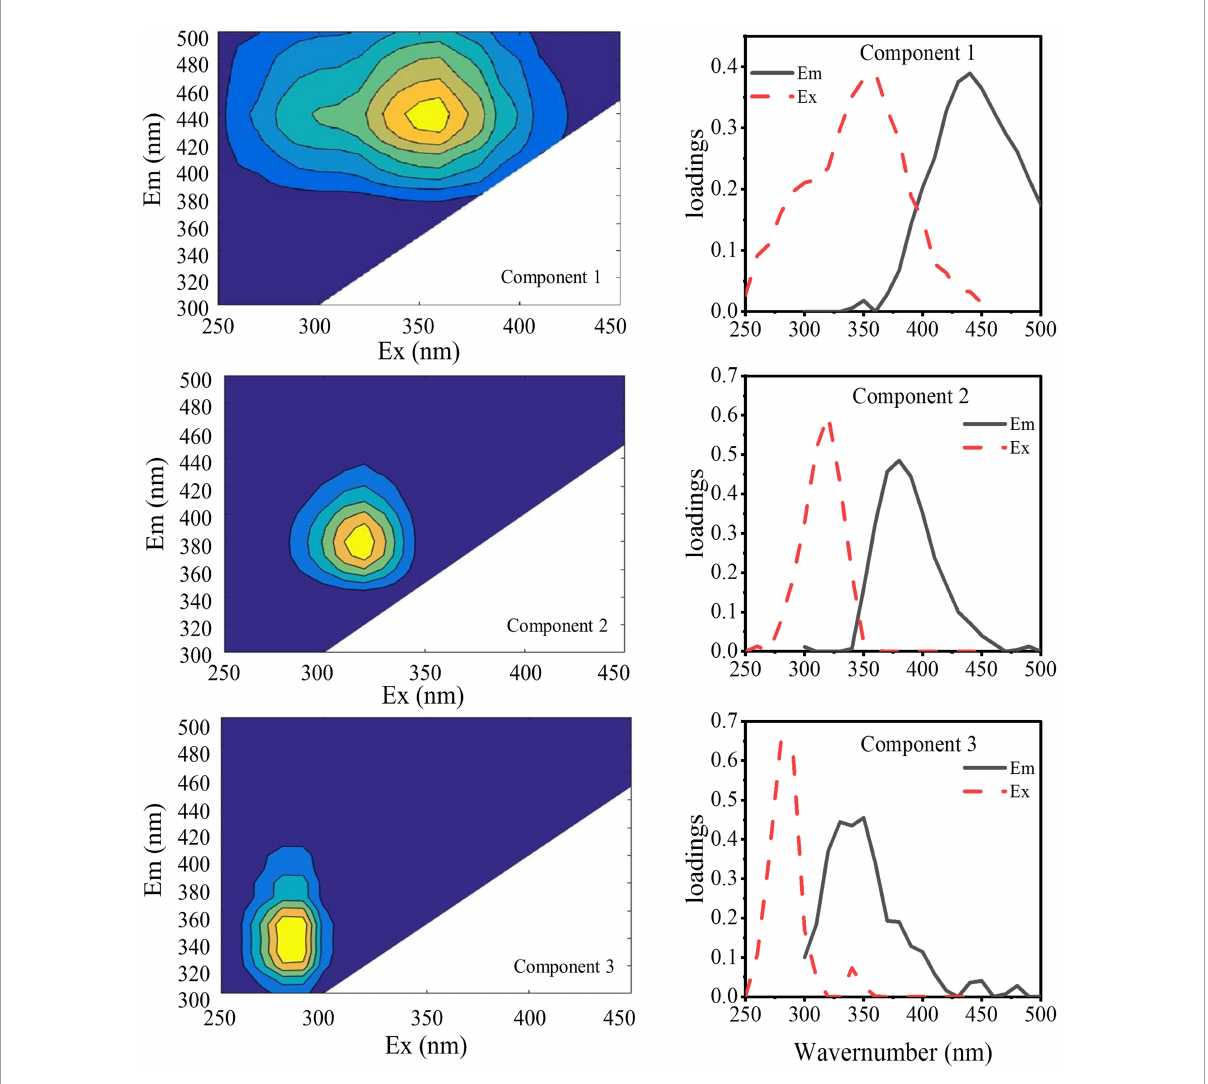
FIGURE4 EEM contours, emission (solid lines) and excitation (dotted lines) loading of the three components identified by the DOMFluor-PARAFAC analysis for EPS produced by A. flos-aquae (Component 1, Component 2, and Component 3 were obtained by PARAFAC of 48 fluorescence EEM data